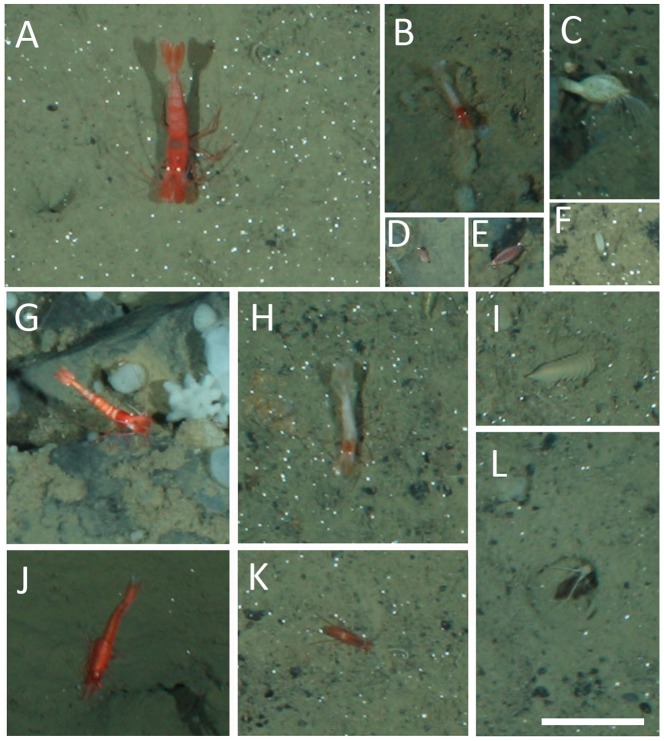
Crustaceans observed at the deep reef.A, Bythocaris leucopis; B, small red-and-white shrimp; C, Verum striolatum; D, Lysianassidae sp. 1; E, Lysianassidae sp. 2; F, small white isopod; G, dunce hat shrimp; H, fantail shrimp; I, Saduria megalura; J, Birsteiniamysis inermis; K, Halirages cainae; L, Neohela lamia. Scale bar  = 5 cm.